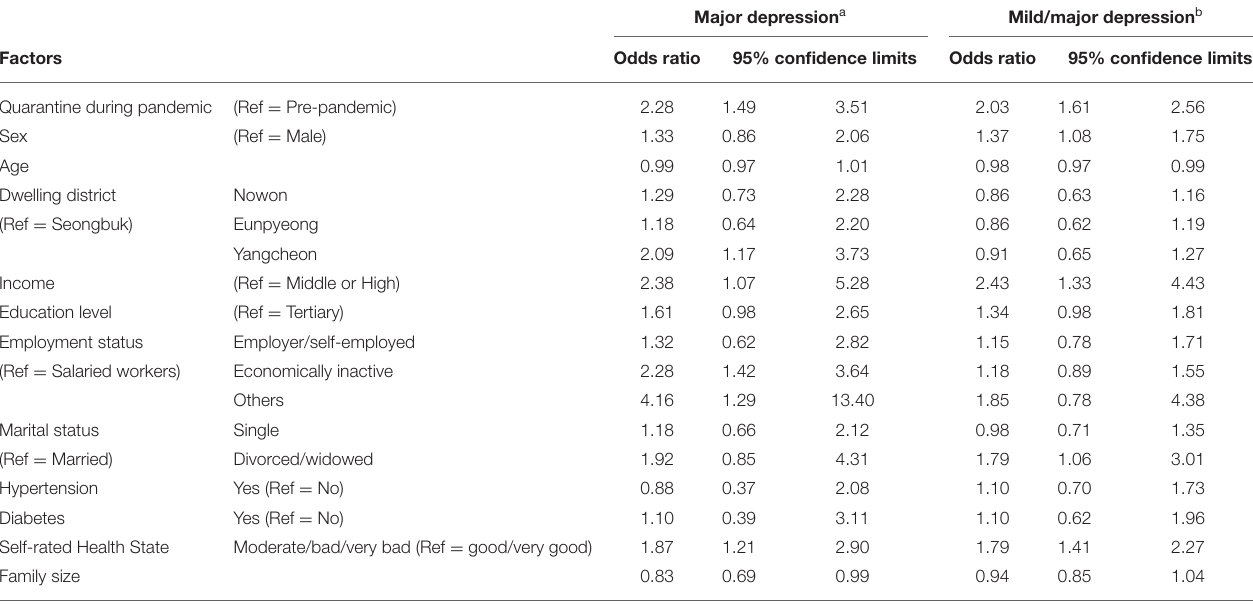
TABLE 3 | Association between quarantine during the COVID-19 pandemic and depression among the matched sample ( N =